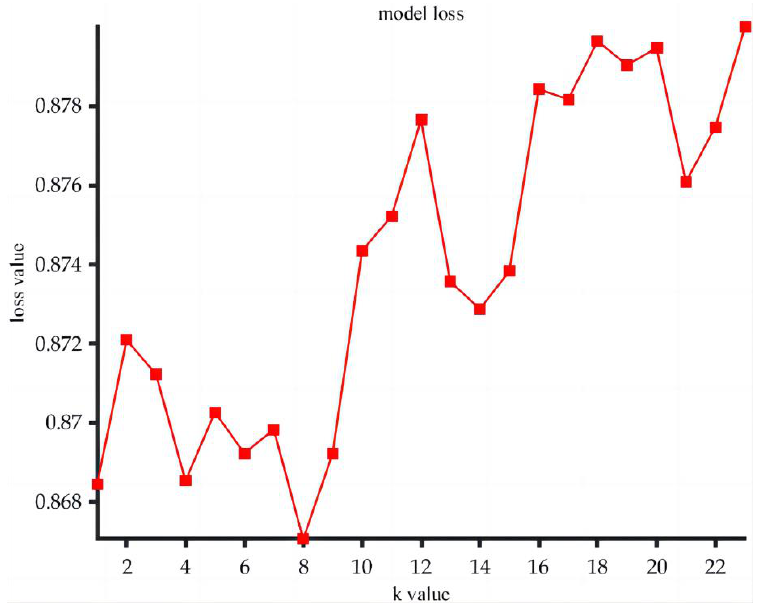
Figure 6. Loss values corresponding to different k values.